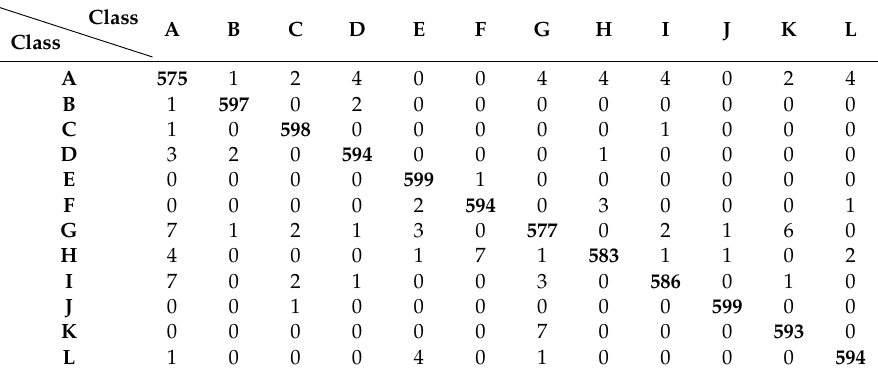
Table 16. Classification results using MLP secondary classifier.